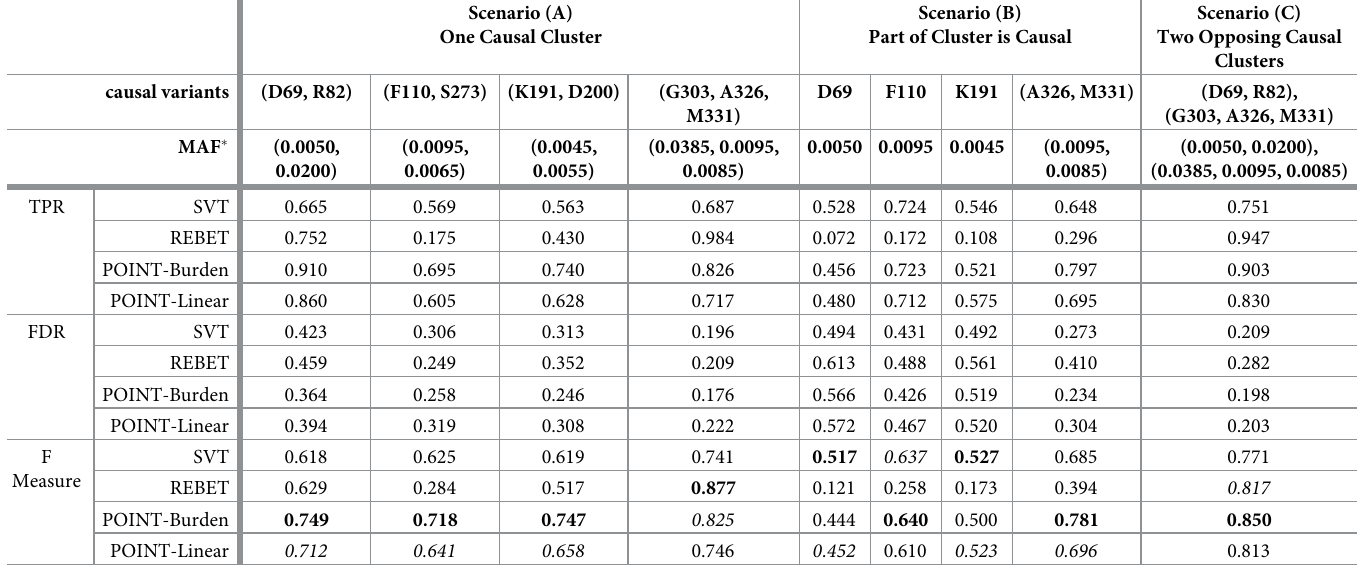
Table 2. Selection performance of continuous-trait simulation with n = 2000 subjects. Selection performance for single variant test (SVT), REBET, POINT test using local burden kernel (POINT-Burden), and POINT test using local linear kernel (POINT-Linear). The best performed methods (based on the composite F-measure) are shown in bold and the second best are shown in italic